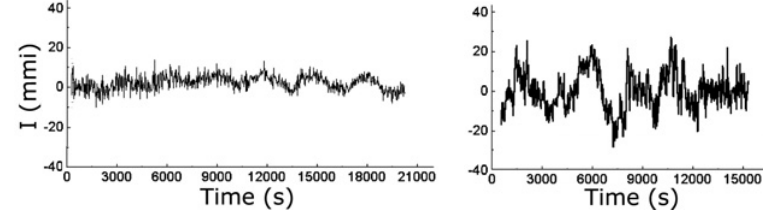
Fig. 5. Comparison of the NGC 246 light curves. The left panel shows a light curve from the 2000 campaign with NOT, while the right panel shows the curve obtained on September 18, 2001 with